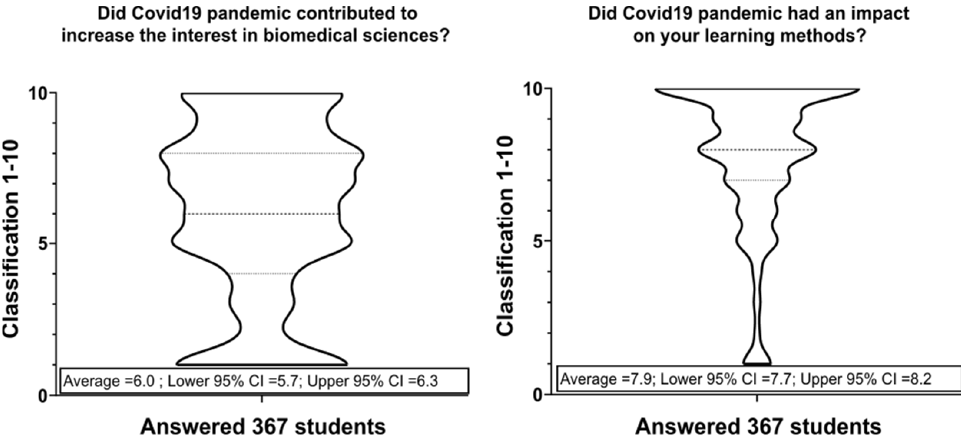
Figure 5. Impact of COVID-19 pandemic on students’ interest in biomedical sciences and habits of study.